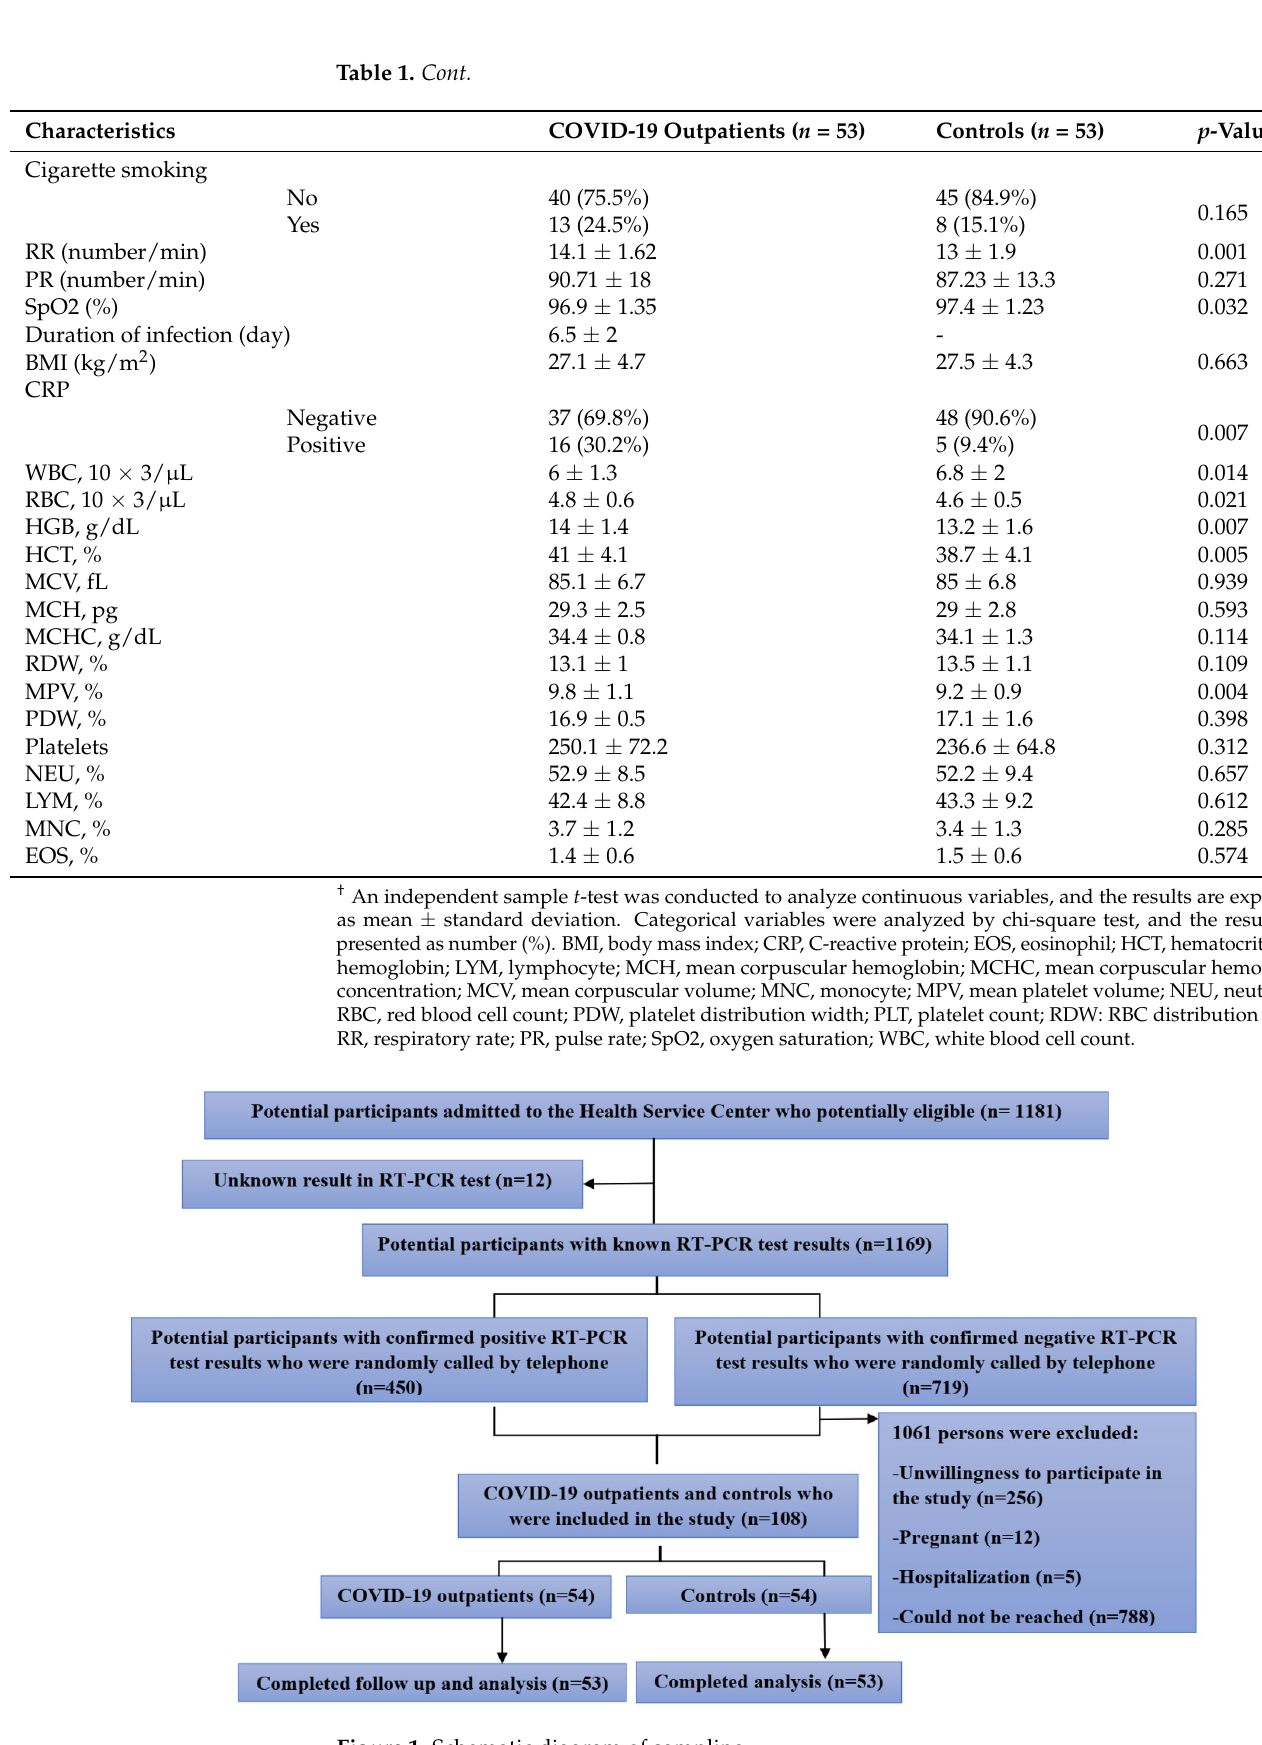
Figure 1. Schematic diagram of sampling.